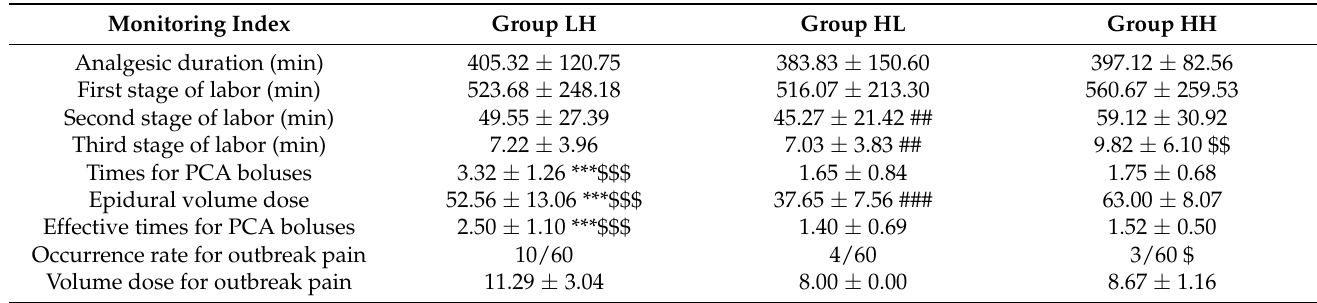
Table 3. Comparison of duration of analgesia, stage of labor, PCEA boluses, and drug consumption among the three groups.